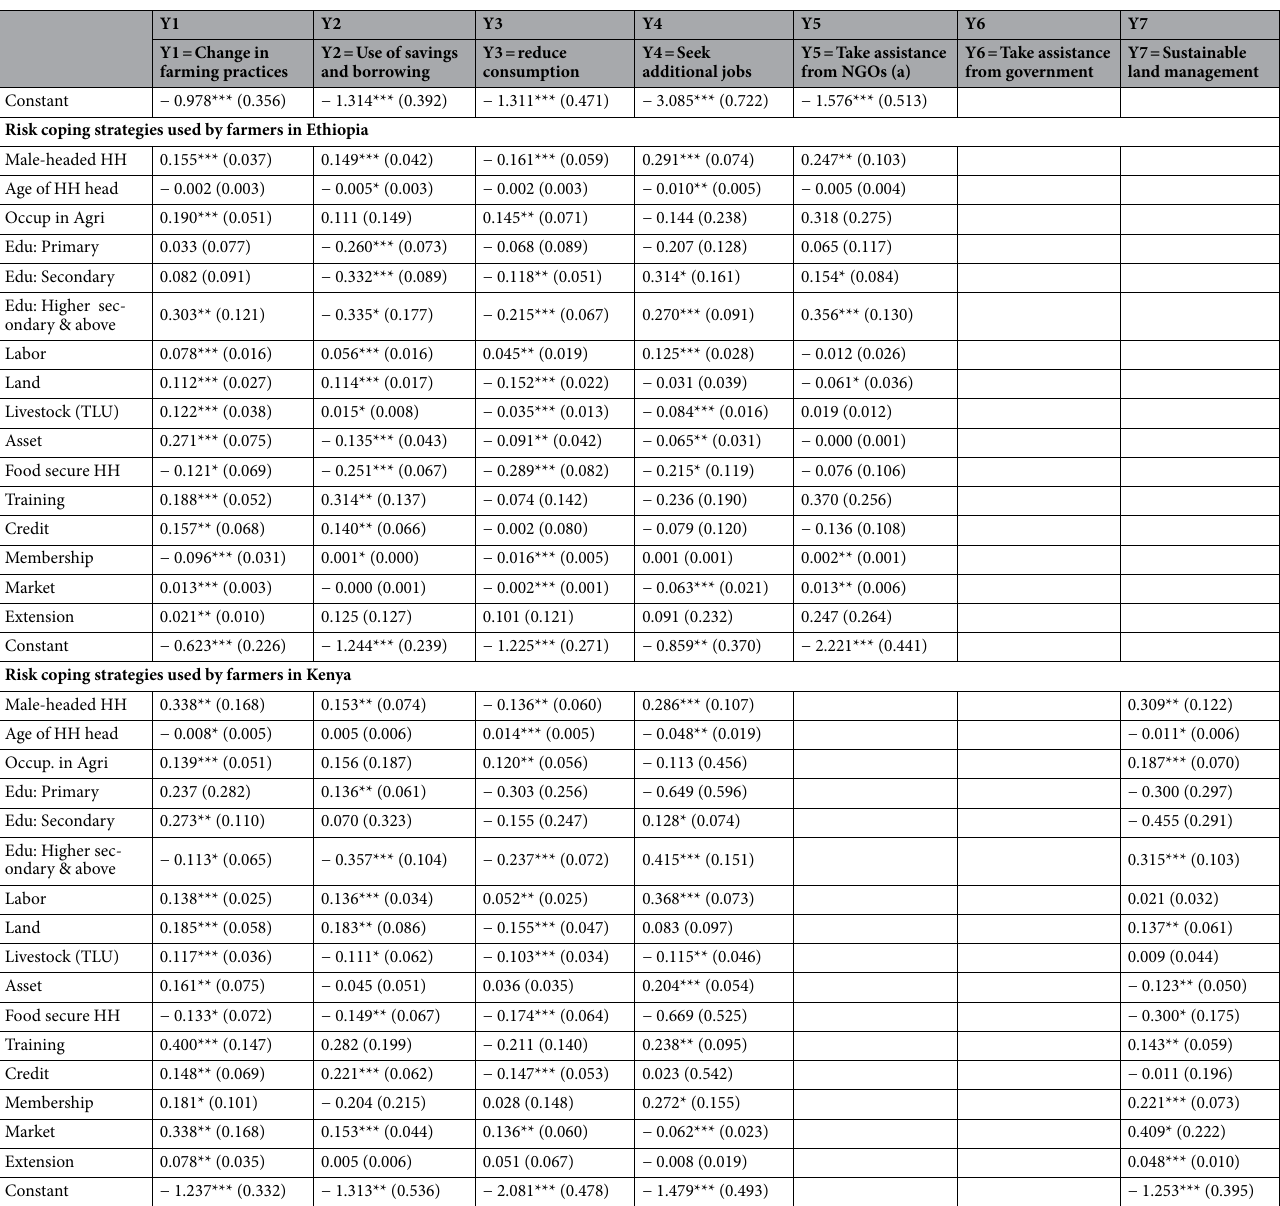
Table 2. Choice of multiple risk coping strategies by farmers in Bangladesh, India, Nepal, Ethiopia and Kenya. For Bangladesh: Log likelihood = − 1912.31; Wald chi-square (96) = 163.14; Prob > Chi-square = 0.000. For Bihar (India): Log likelihood = − 1187.69; Wald Chi-square (80) = 151.23; Prob > Chi-square = 0.000. For Terai (Nepal): Log likelihood = − 1001.64; Wald Chi-square (80) = 162.95; Prob > Chi-square = 0.000. For Ethiopia: Log likelihood = − 1001.64; Wald Chi-square (80) = 162.95; Prob > Chi-square = 0.000. For Kenya: Log likelihood = − 1001.64; Wald Chi-square (80) = 162.95; Prob > Chi-square = 0.000. Y1 change in farming practices, Y2 use of savings and borrowing, Y3 reduce consumption, Y4 seek additional jobs, Y5 take assistance from government (for India and Nepal it refers to taking assistances from both governmental and/or non- governmental organizations), Y6 take assistance from non-governmental organizations, Y7 Sustainable land management. *, **, ***Refer to 10, 5 and 1% level of significance, respectively. Standard errors are in